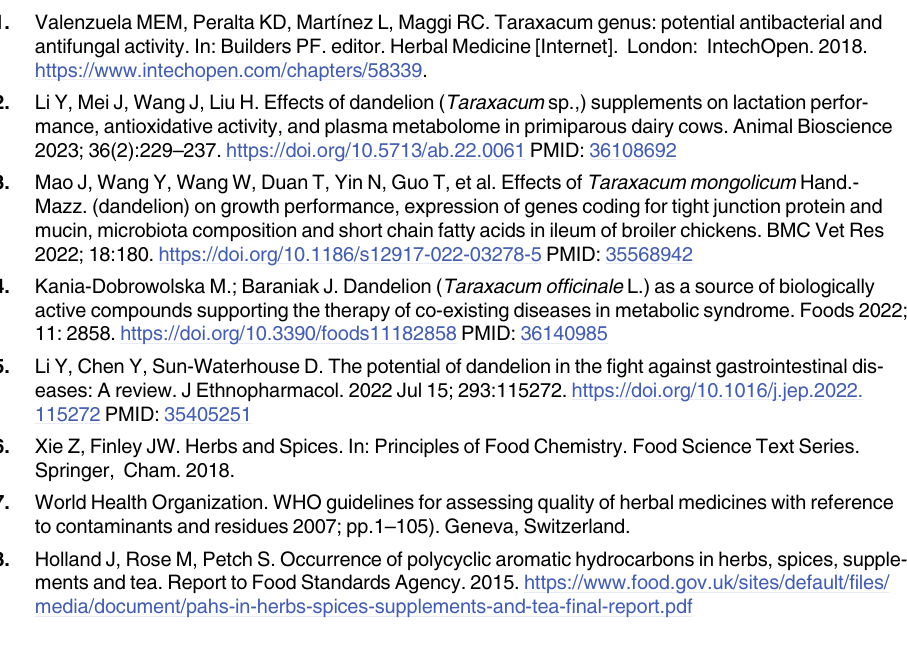
S6 Table. Raw data: (A) concentration of heavy metals, (B) soil pH. (XLSX) S7 Table. Raw data: Microorganisms isolated from Taraxacum officinale and soil.